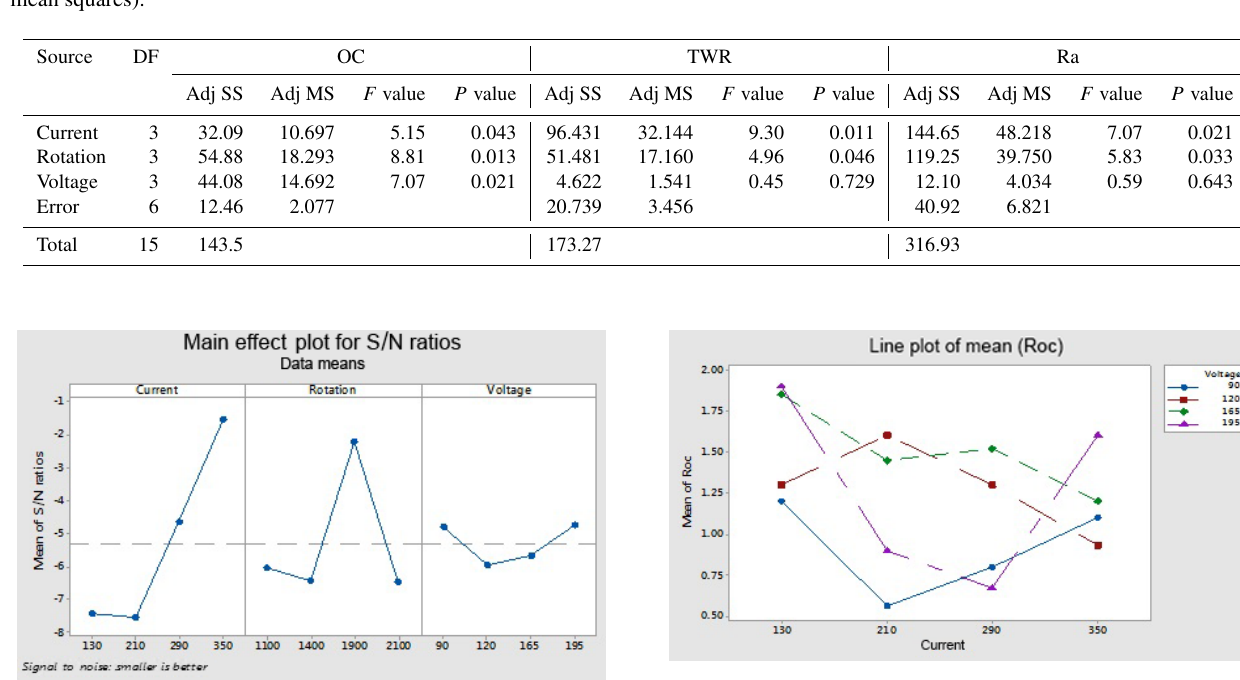
Table 6. Analysis of variance (ANOVA) for S/N ratio of non-cryogenic electrode (Adj SS – adjusted sums of squares; Adj MS – adjusted mean squares).